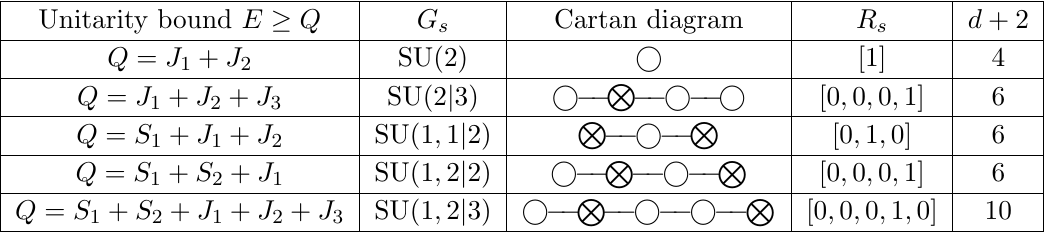
Table 1 . Five unitarity bounds of N = 4 SYM that give rise to SMTs in the limit (4.2). For each limit we list the spin group G s , the Cartan diagram for the corresponding algebra and the representation R s of the algebra (in terms of Dynkin labels) that de(cid:12)nes the Spin Matrix Theory for a given limit. Moreover, d +2 is the space-time dimension of the target space for the corresponding sigma-model (see section